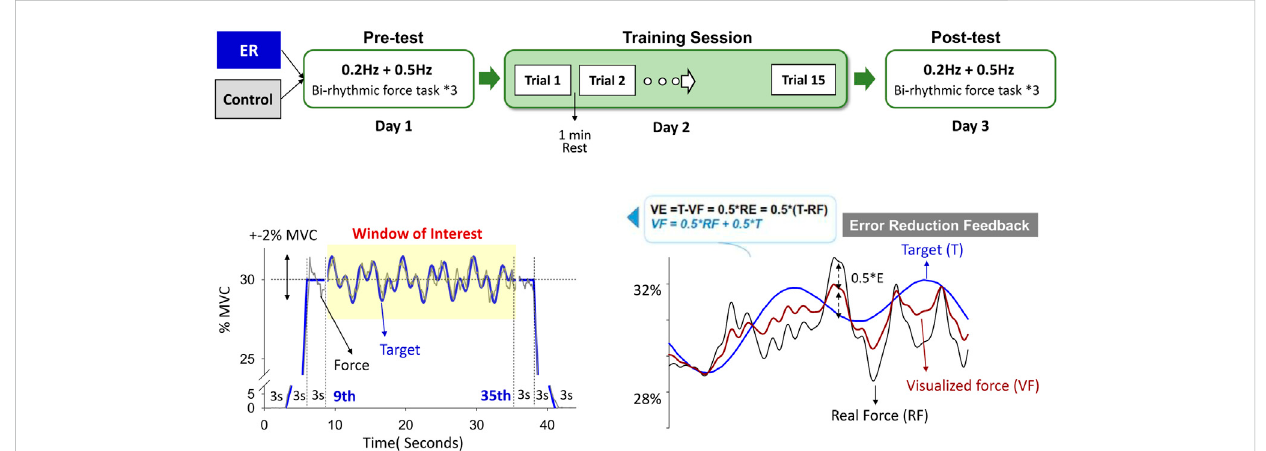
FIGURE 1 Experimental training protocol. The pre-test (Day1) and post-test (Day 3) consisted of a bi-rhythmic force task to contrast the short-term training effect using feedback with no reduction in errors (control) and error reduction (ER) feedback. The bi-rhythmic task required the subjects to track a visual target that combined sinusoidal waves of 0.2 Hz and 0.5 Hz fl uctuating around 30% ± 2% MVC (subplot in the lower left). With simple mathematical transformation (subplot in the lower right), the subject perceived errors reduced by 50% with error reduction feedback during training. The force outputdisplayedonthemonitor(visualizedforce,VF)wasequal tothesumofhalfoftherealforce(RF)plushalfofthetargetsignal (T)(VF=0.5*(RF+T)). Hence,thesizeofthevisualizedtrackingerrorwashalf oftherealerror(RE)oftheforce-trackingtask(VE=T-VF=T-0.5*(RF+T)=0.5*(T-RF) =0.5*RE). The training task in Day 2 was the same bi-rhythmic force